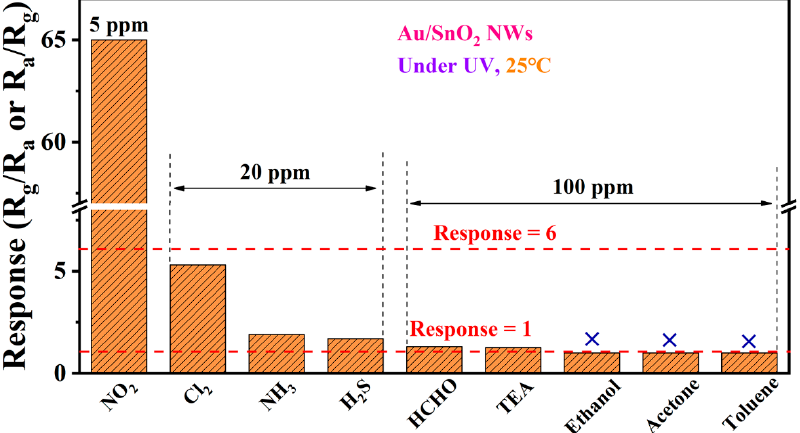
Figure 9. Responses of the sensor based on Au/SnO 2 NWs toward 5 ppm NO 2 and common interfering gases with higher concentrations at RT under UV irradiation (0.42 mW/cm 2 ).